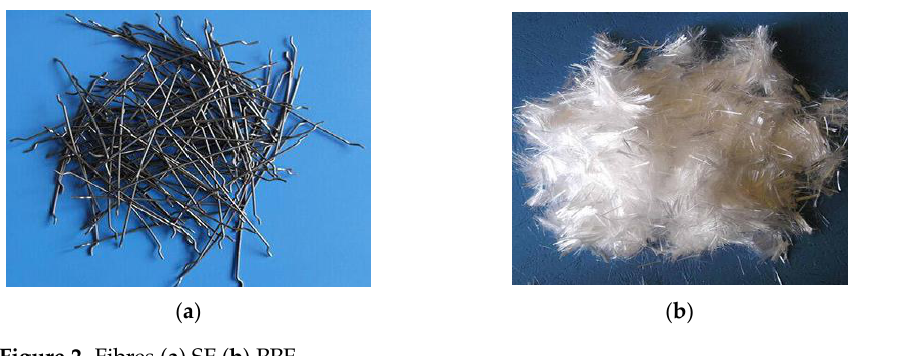
Figure 2. Fibres ( a ) SF ( b ) PPF. Table 5. Properties of the fibres.